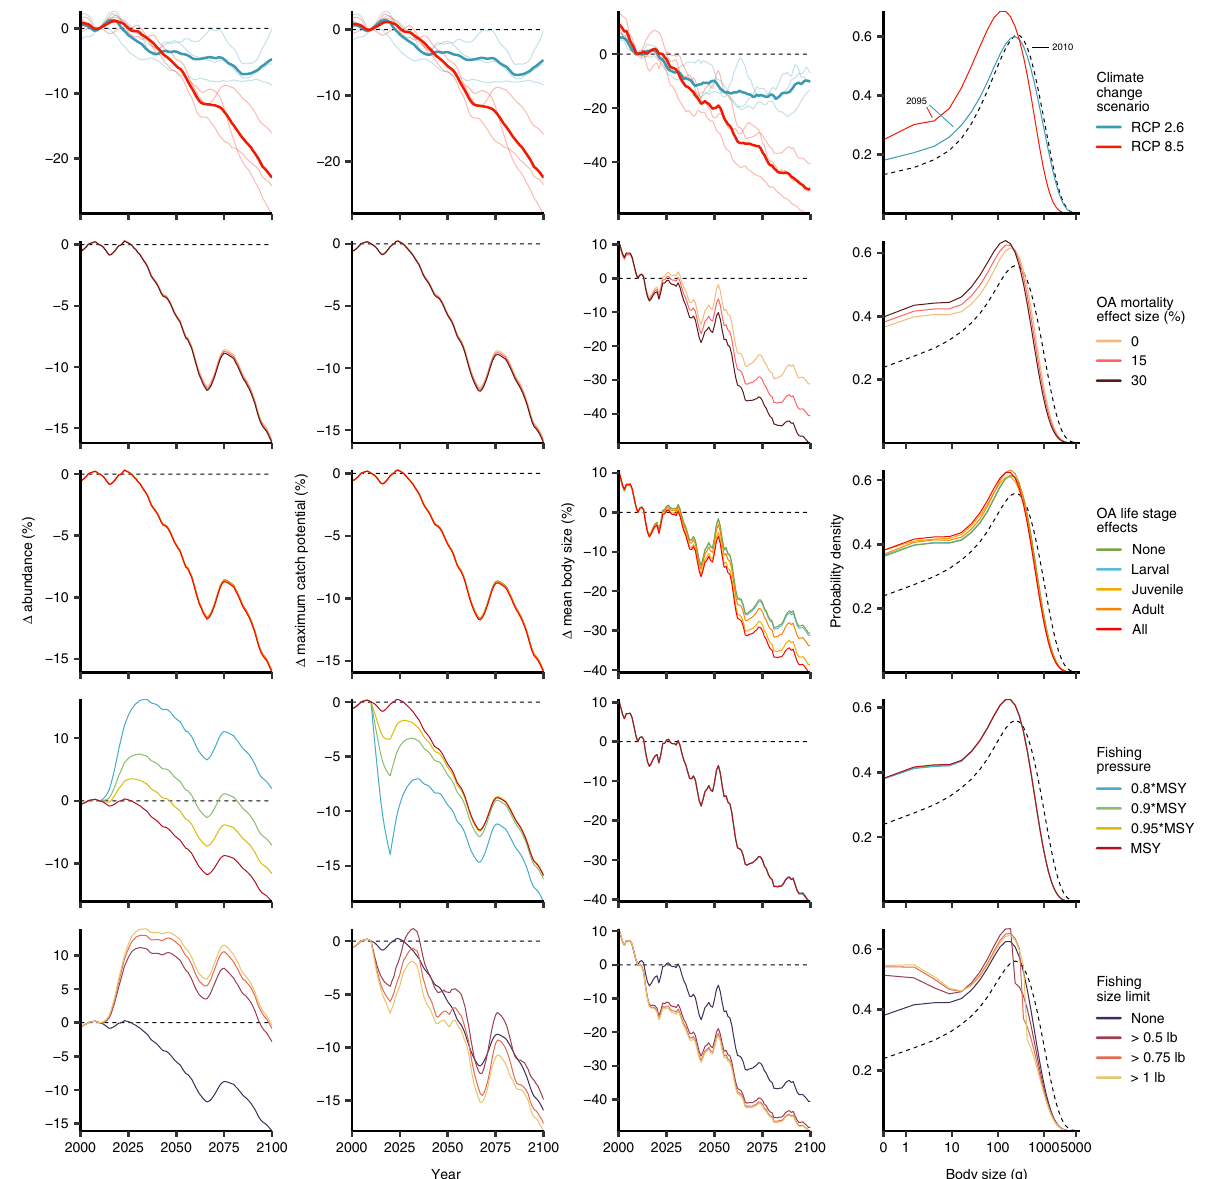
Figure 1. Alternative model parameter settings and their effects on abundance, maximum catch potential, and body size for the American lobster, Homarus americanus . While exploring change for each parameter, other parameters were held constant, such that: earth system model = GFDL; climate change scenario = RCP 8.5; OA effect size = 15%; OA effects on life stage = all; fishing pressure = MSY; fishing size limit = none. Dashed lines are the relative value in 2010, while coloured lines are temporal trends in the first three columns, and a snapshot of the population’s body size distribution in year 2095 in the far-right column. Values are relative to 2010 and are smoothed with 10-year running